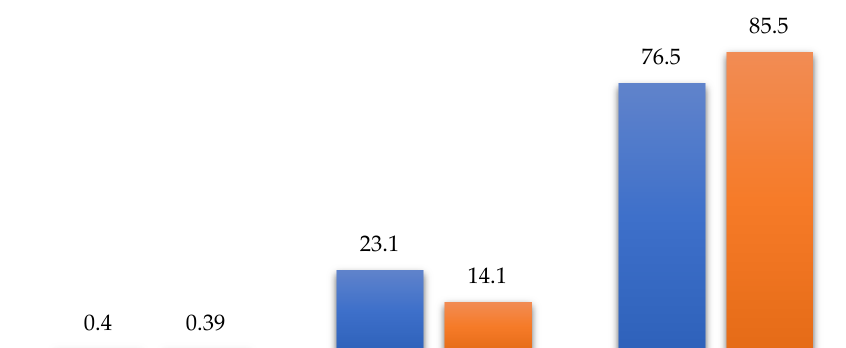
Figure 1. MBI scores for social workers and clerics.